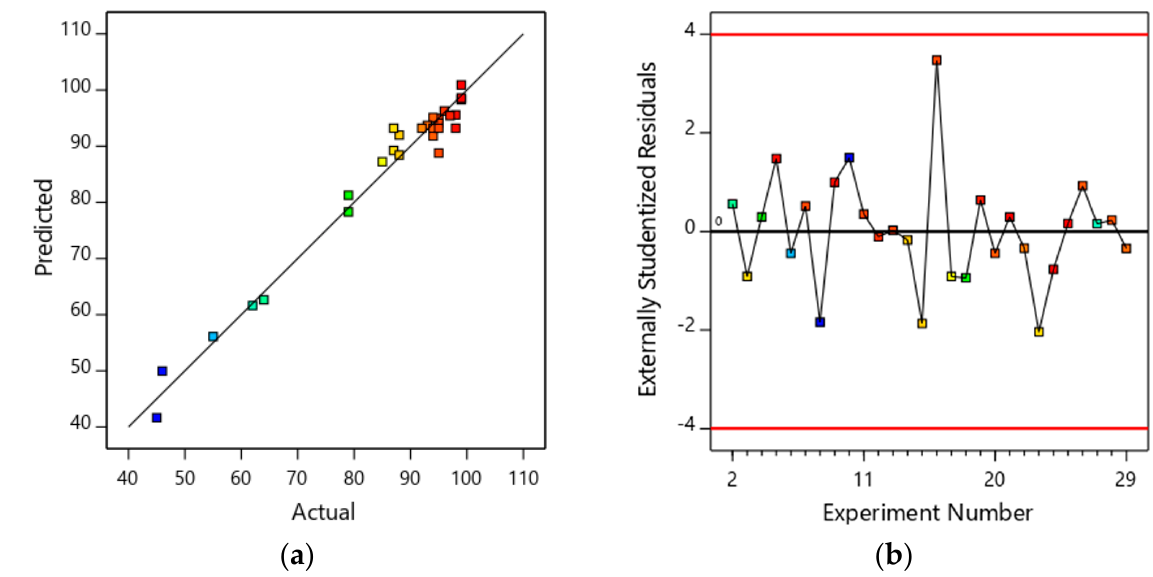
Figure 2. Comparison of predicted and experimentally determined conversion values ( a ); distribution of residues, r s depending on the ordinal number of the experiment ( b ). Table 3. Part of ANOVA for quadratic